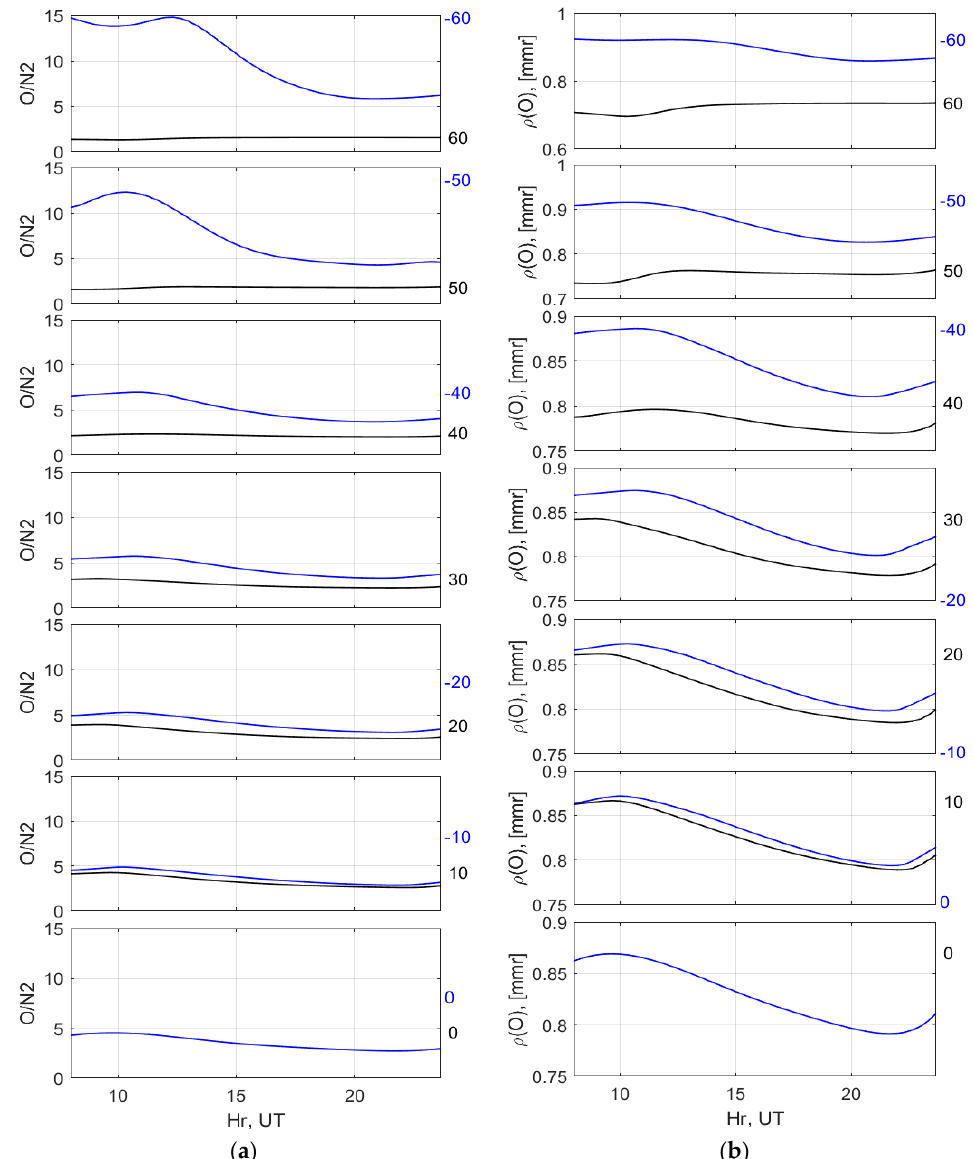
Figure 13. TIEGCM-simulated O/N 2 ratio ( a ) and O ( b ) at a fixed longitude of 65°W. The blue line represents the O and O/N 2 ratio in the southern hemisphere (SH). The black lines represent the O and O/N 2 ratio in the northern hemisphere (NH).